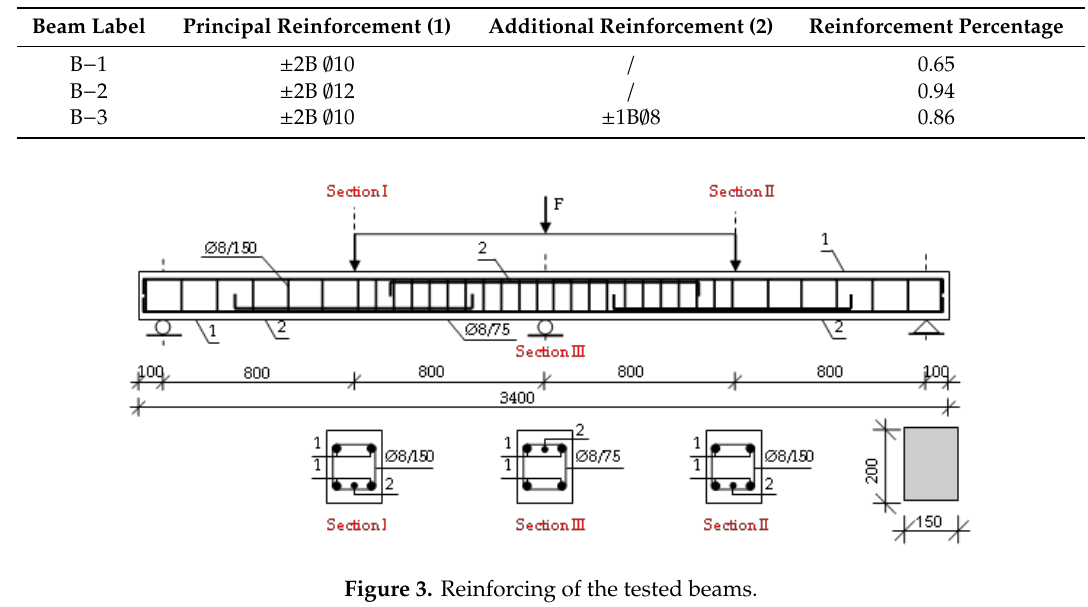
Figure 2. Stress–strain relation for concrete under compression.